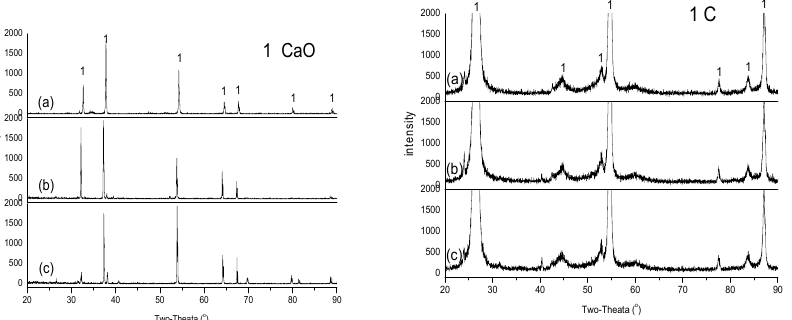
Figure 1. XRD analysis: ( a ) CaO and pure-C (1500 °C); ( b ) CaO+pure-C (1500 °C); ( c ) CaO+pure-C (1700 °C).